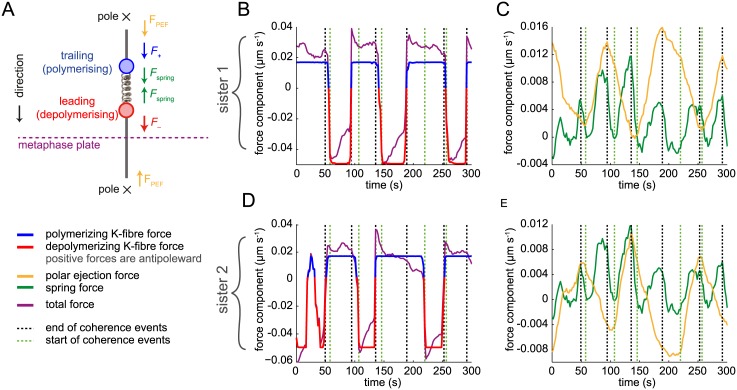
Force decomposition profile.(A) Schematic of the forces acting on kinetochore sisters. (B-E) Estimated decomposition of kinetochore velocity into its force components over time for the trajectory in Fig 1C; (B, D) sister 1 and (C, E) sister 2. Polymerisation/depolymerisation force on kinetochores attributable to the K-fibre (blue/red, respectively); spring force (green); polar ejection forces (orange) and the total force (purple). Time-series overlaid with inferred end (black dashed) and start (green dashed) times of coherence periods (runs). Between end and start times K-fibres are incoherent (in this case +/+) Note that forces are positive in the anti-poleward direction.